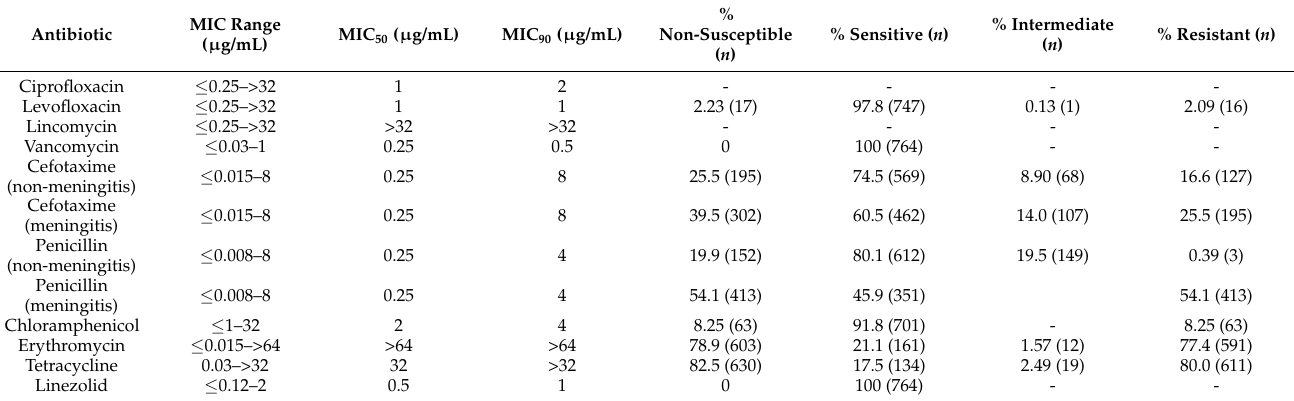
Table 4. Minimum inhibitory concentrations of Streptococcus pneumoniae to 10 antibiotics (N = 764). Antibiotic